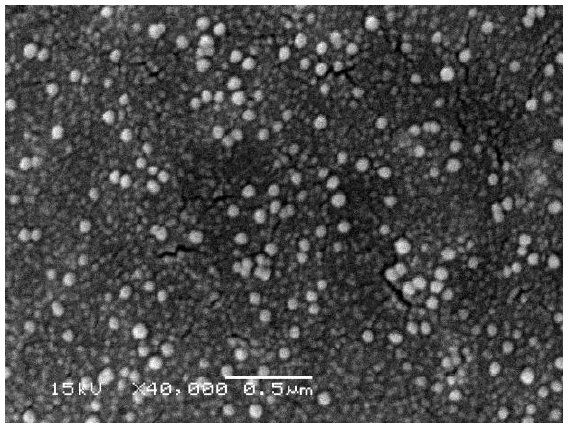
Figure 2. SEM of well dispersed spherical nanoparticles suspended on agarose gel.